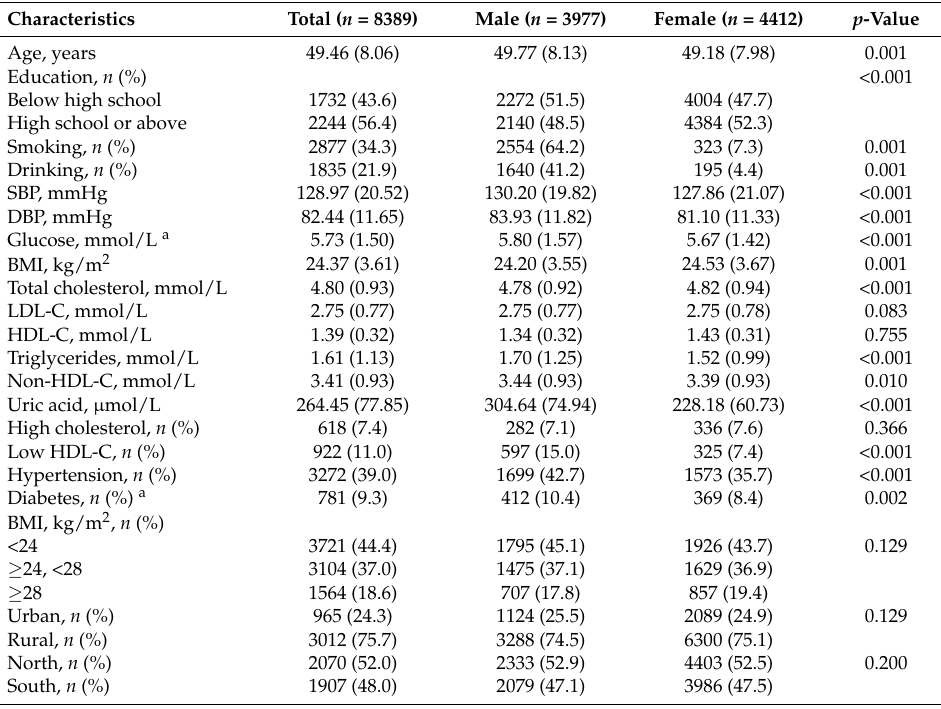
Table 1. Baseline clinical and laboratory